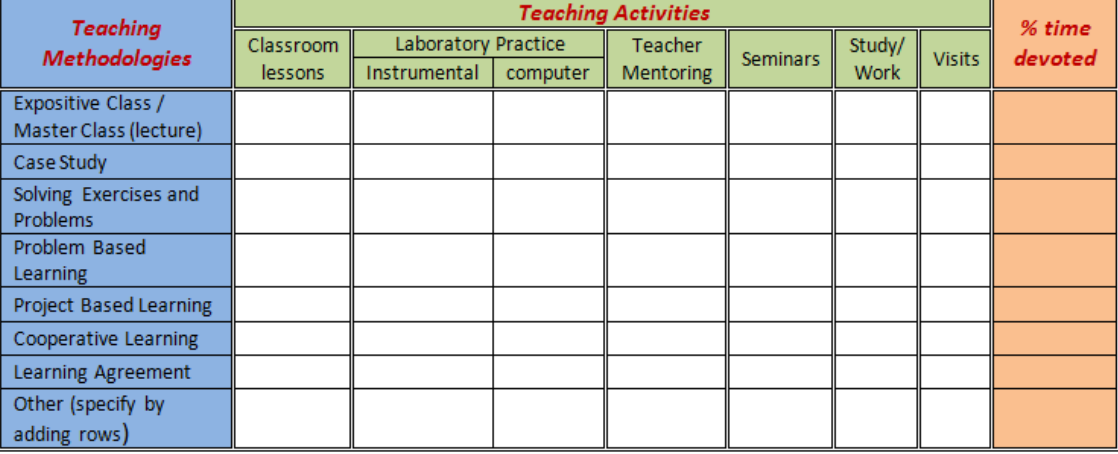
Fig. 2. Teaching methodologies card: Methodologies vs. teaching activities.